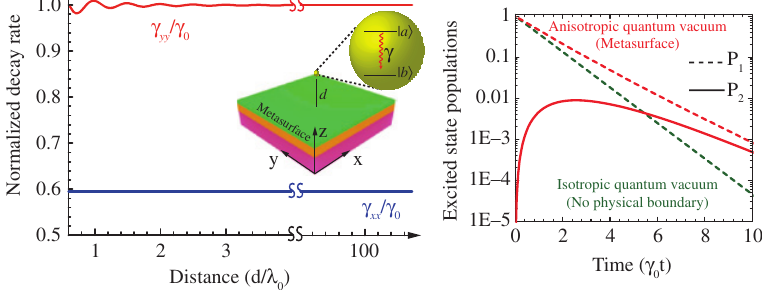
Figure 9: Metasurface-enabled in-plane anisotropic decay rate and population-coherence coupling. (Left) Decay rate of x -dipole (blue curve) and y -dipole (red curve) against the distance from the metasurface and (right) Plot of the population > in the presence (red curves) and absence (green curve) of the metasurface. Reprinted from Ref. [23]. Copyright © 2015 by of the level | a 1,2 the American Physical Society.